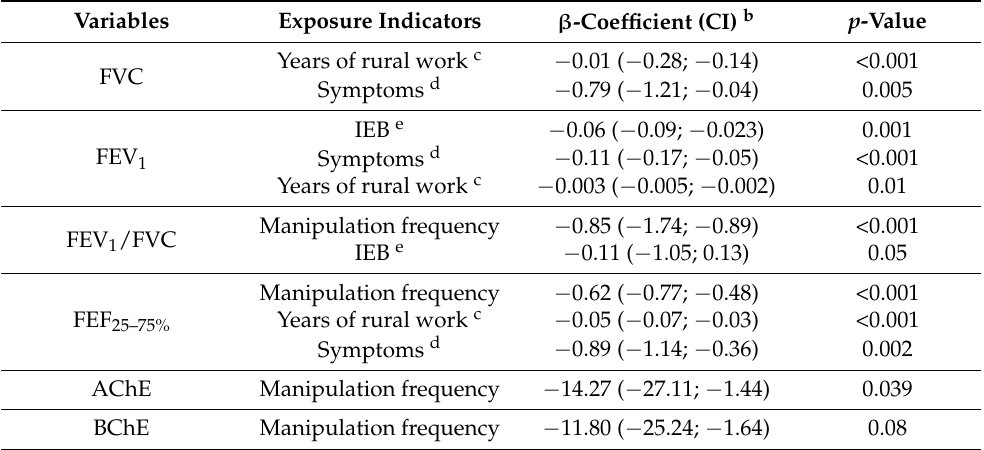
Table 4. Multiple regression models a of spirometry variables (in percentages of predict) and cholinesterase levels on exposure indicators during the crop season in SJU. 2014.